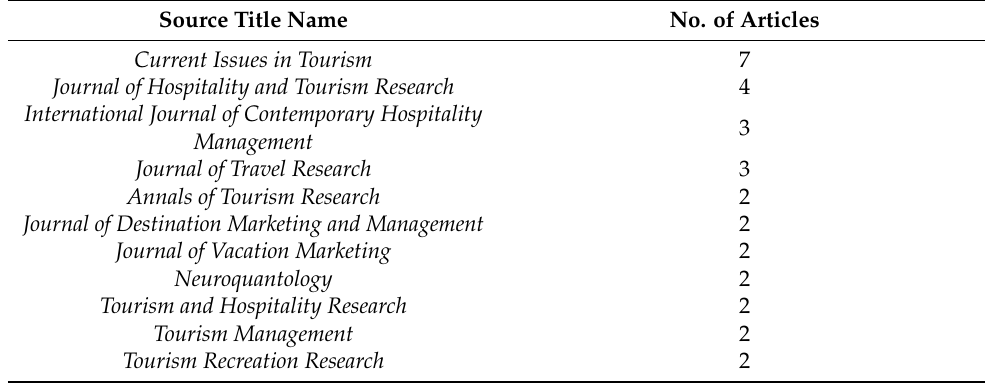
Table A1. Article classification by most-used